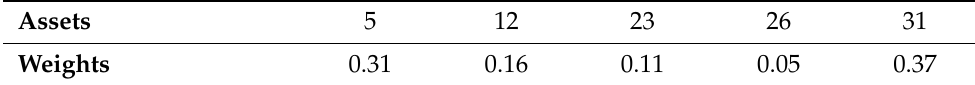
Table 1. Example: Assets and their corresponding